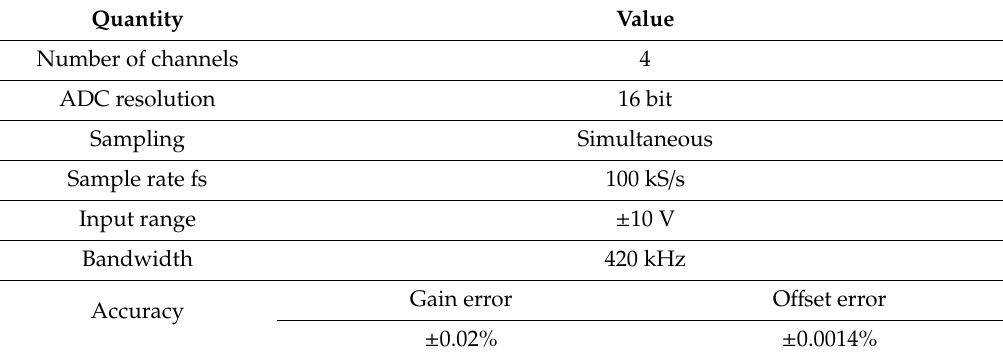
Table 3. Technical data for the NI 9215 acquisition module.